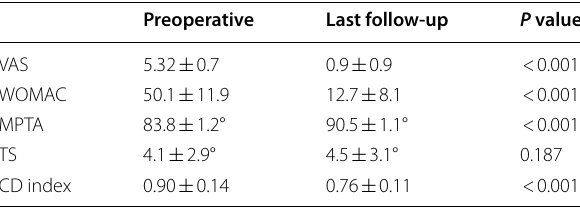
Table 3 Clinical and radiographic